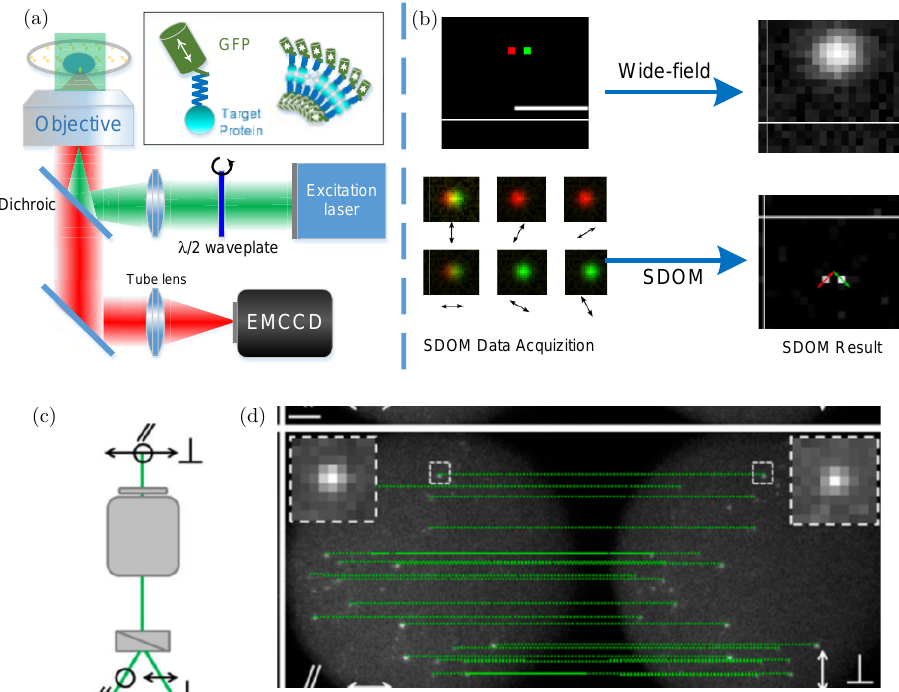
Fig. 3. Principle of SDOM and polar-dSTORM. (a) Setup of SDOM: The rotary linearly polarized laser is realized by continuously rotating a half-wave plate and incorporated into a wide-¯eld epi-°uorescence illumination microscope. The polarization-modulated images are collected by an EMCCD camera, which is in synchronization with the rotary mount. When the °uorophores are linked to the target protein, the dipole orientations indicate the structural information of target proteins. (b) Illustration of the principle of SDOM: through linearly polarized excitation, two neighboring °uorophores (pseudo color in red and green) with 100 nm distance and di®erent dipole orientations emit periodic signals. With SDOM, two emitters can be distinguished and the dipole orientation can be determined. Arrows indicate the directions of dipole orientations. (c) Schematic setup of polar-dSTORM: circularly polarized laser is used for epi-illumination. The perpendicular ( ? , the vertical axis of the sample plane) and parallel ( jj , the horizontal axis of the sample plane) polarization states are split by a Wollaston prism and recorded by the EMCCD camera. (d) Principle of polar- dSTORM: two recorded polarization channels of one frame are simultaneously recorded and analyzed. Single dipoles are localized and measured with in-plane orientations. Figures adapted from Refs. 17 and 18.